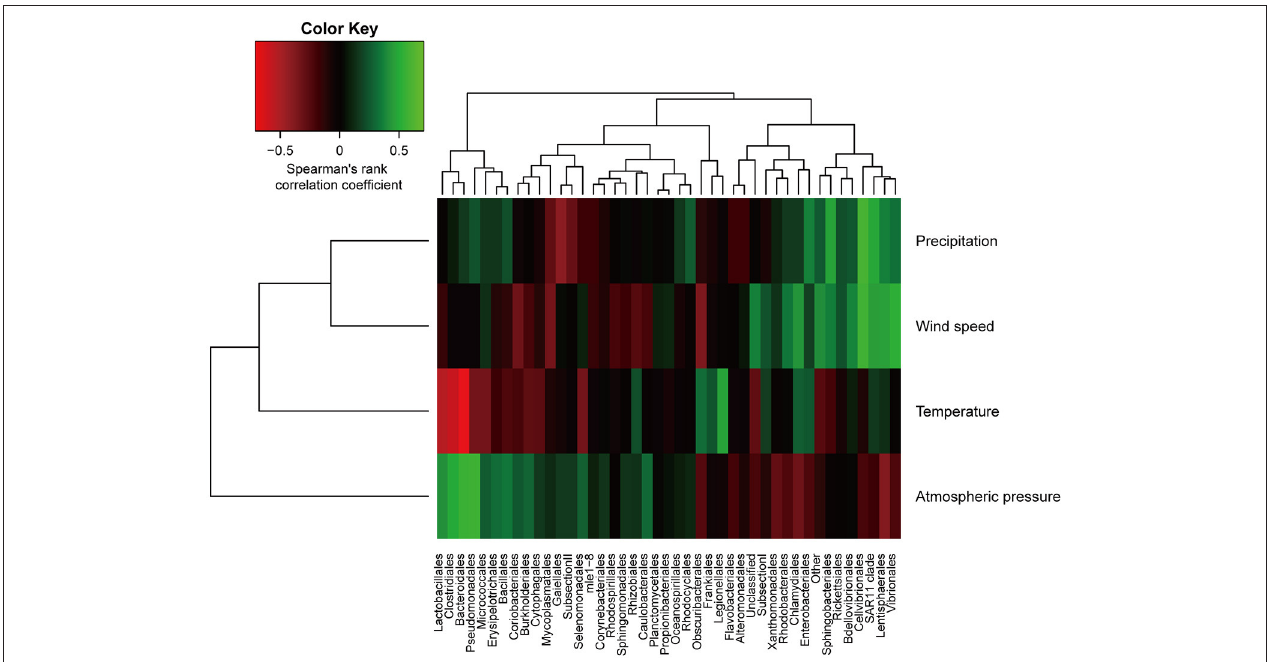
FIGURE 4 | Correlation analysis between relative abundances of sequences at the order level and meteorological data. The color scheme represents Spearman’s rank correlation coefficient.